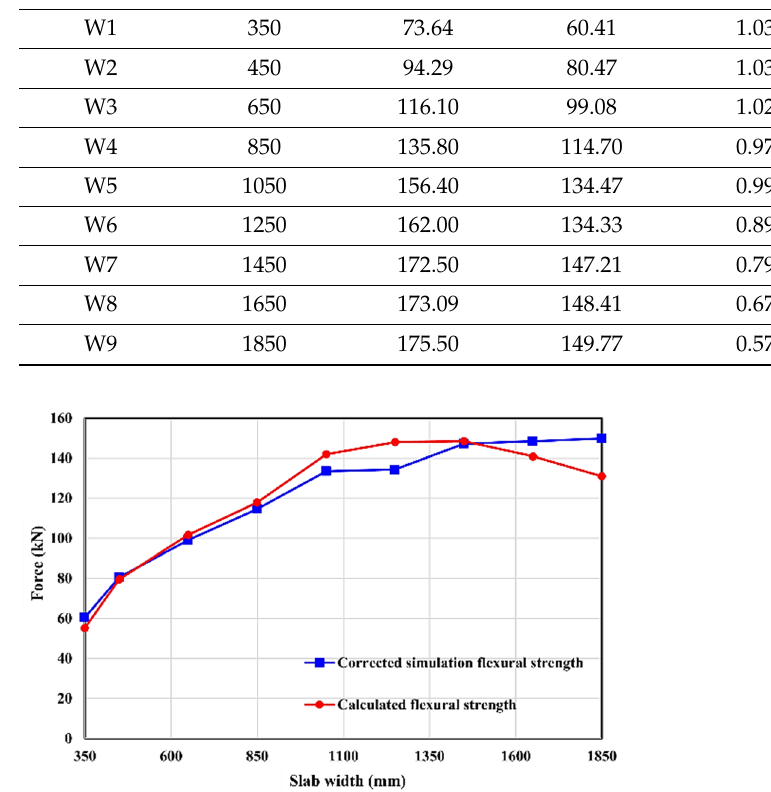
Table 2. FEM results for slab width models.